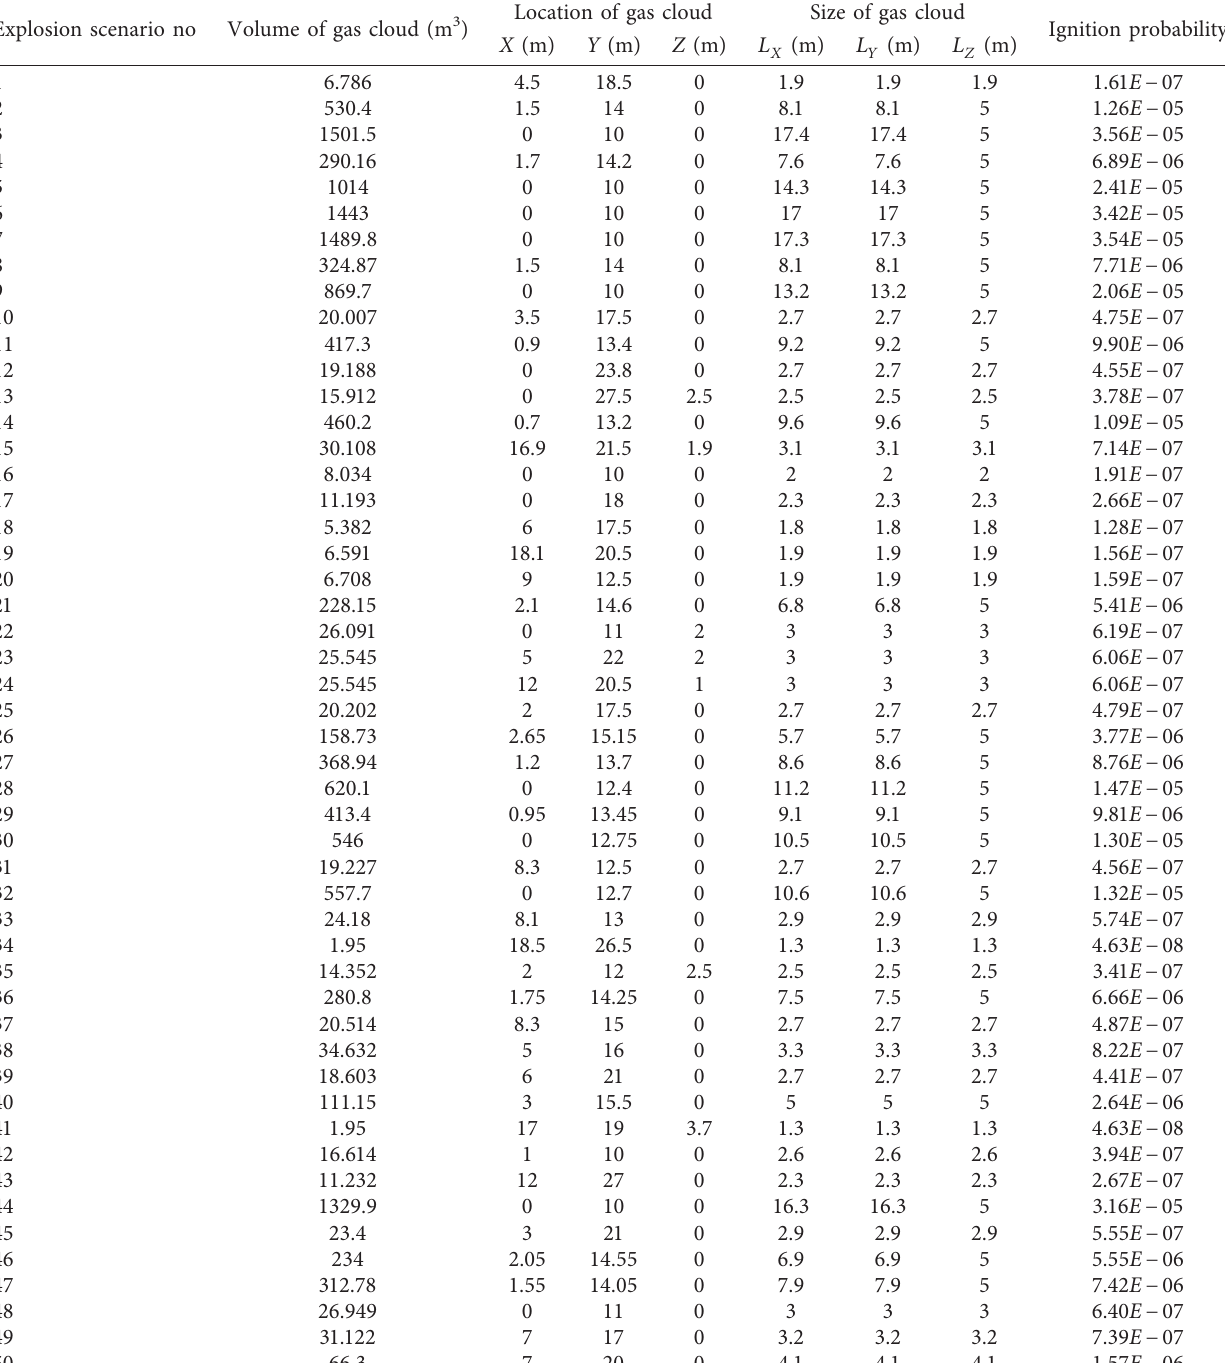
Table 5: 50 explosion